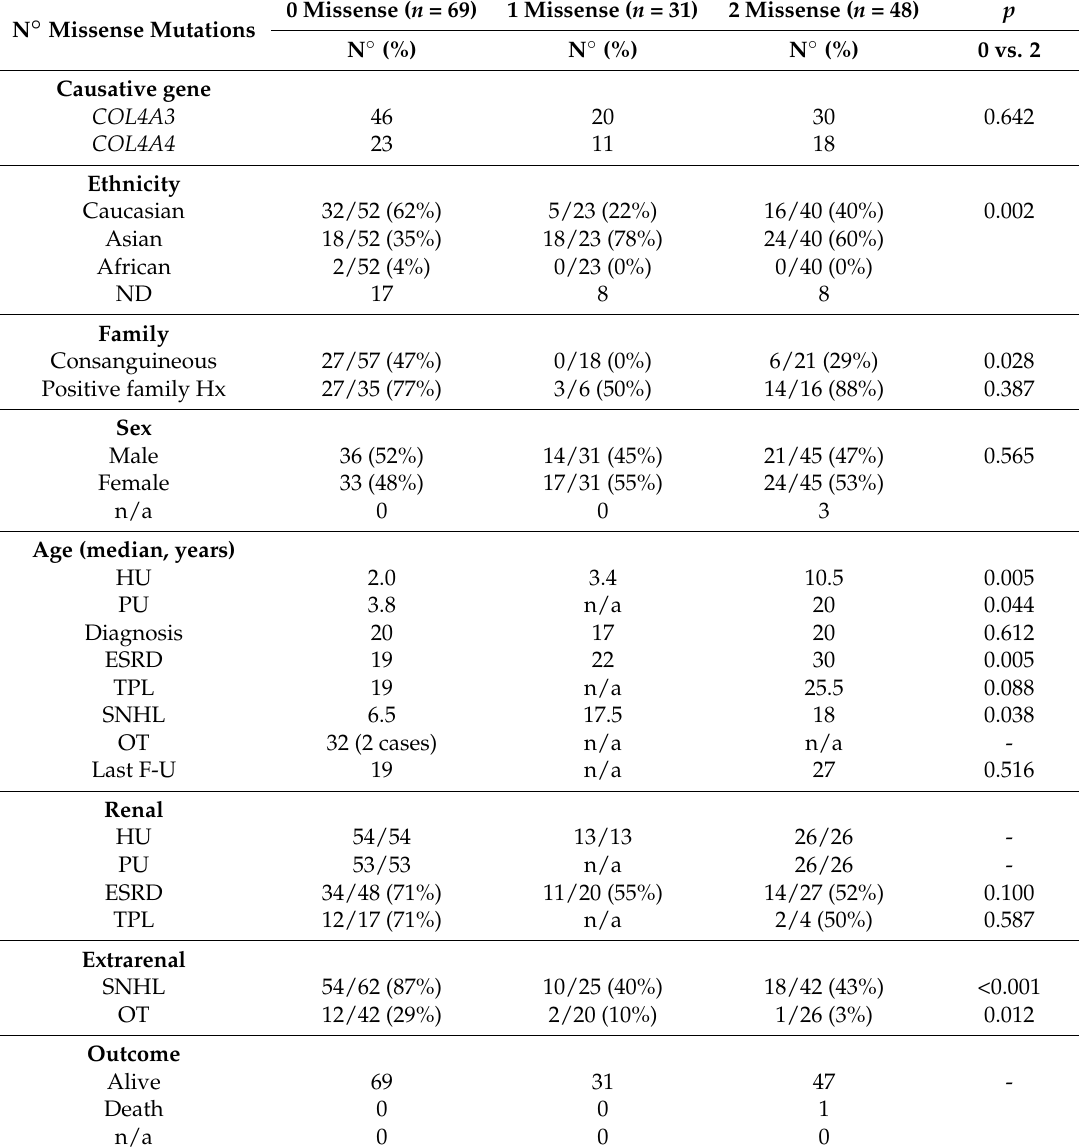
Table 4. Features of ARAS patients according to the number of missense